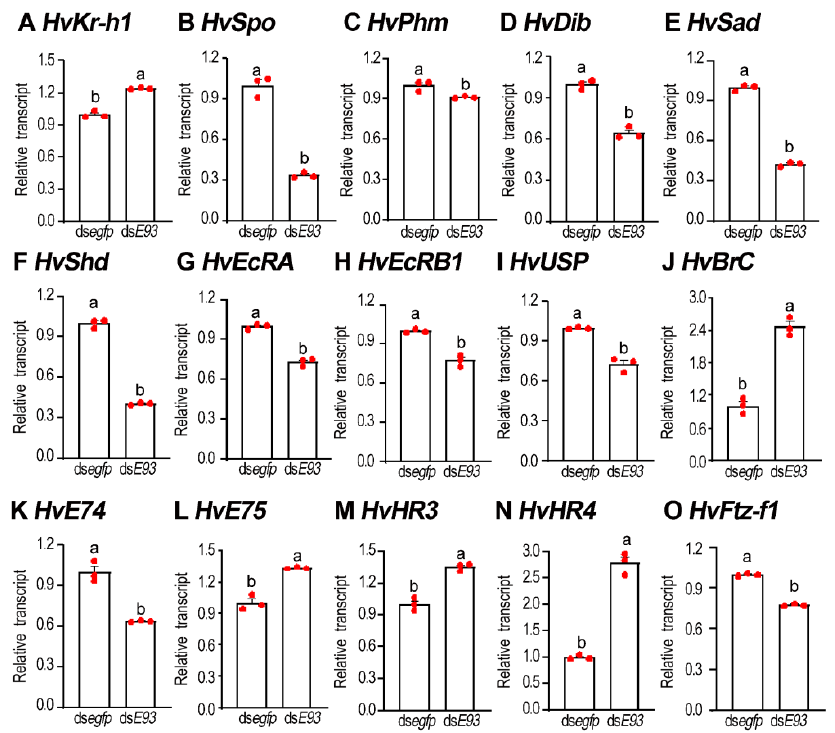
Figure 8. The expression levels of JH and 20E signal genes in the HvE93 fourth-instar larvae in Henosepilachna vigintioctopunctata . Around 500 ng of ds E93 or ds egfp (0.1 µ L) was injected into the newly molted fourth-instar larvae. Three days after injection, the expression levels (2 − ∆∆ CT values) of HvKr-h1 , five Halloween genes ( HvSpo , HvPhm , HvDib , HvSad and HvShd ), three 20E receptor genes ( HvEcRA , HvEcRB1 and HvUSP ) and six 20E response genes ( HvBrC , HvE74 , HvE75 , HvHR3 , HvHR4 and HvFtz-f1 ) were determined. Statistical significances ( p value < 0.05, showing by different letters above the columns) between treatment and control (means ± SE) were calculated using an independent sample t -test.